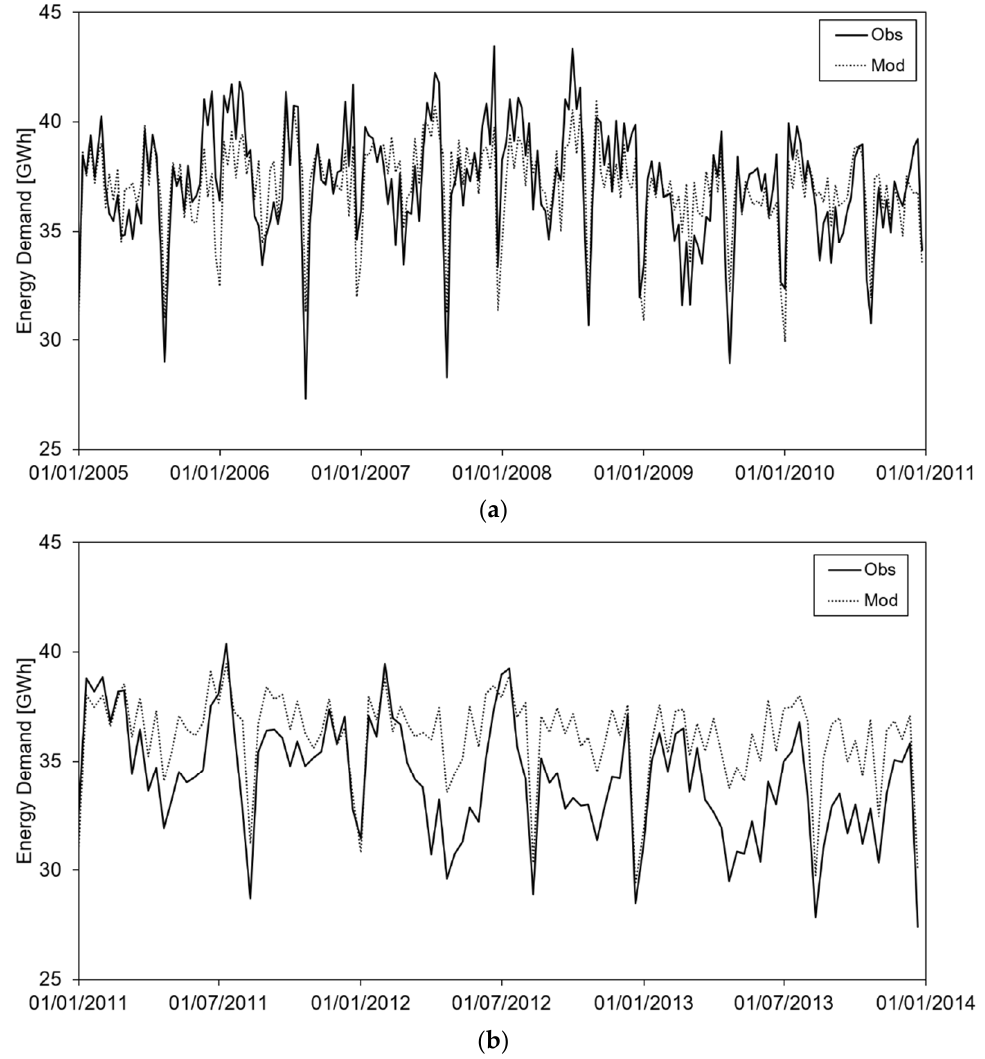
Figure 1. ( a ) Energy demand model calibration; on the x-axis the time period of calibration, on the y-axis the value of daily average energy demand observed and modelled. ( b ) Energy demand model validation; on the x-axis the time period of validation, on the y-axis the value of daily average energy demand observed and modelled.